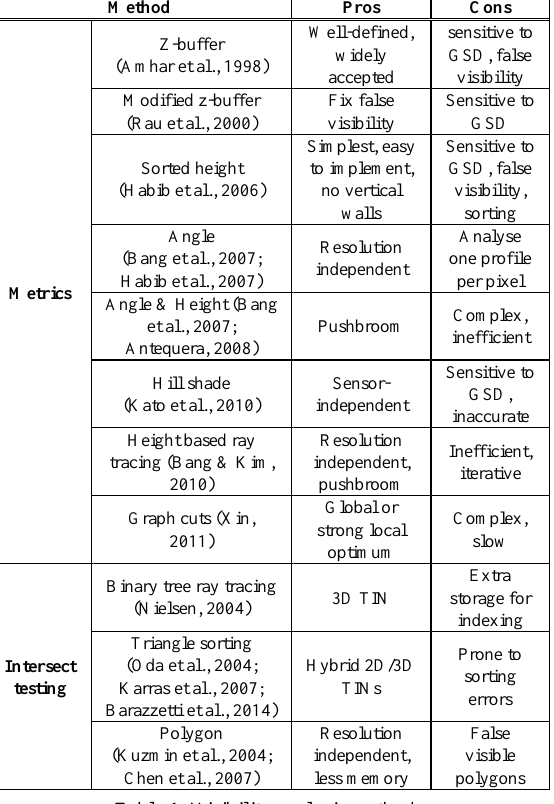
Table 1. Visibility analysis